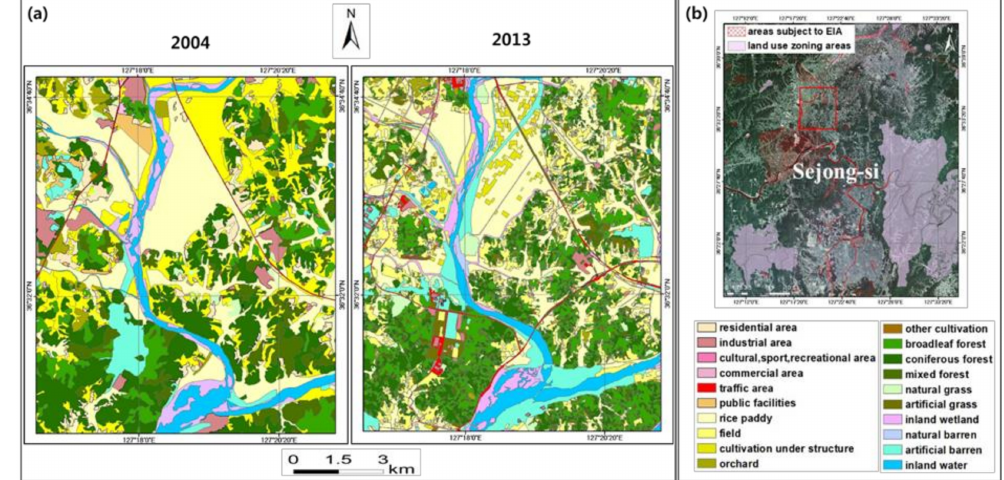
Figure 2. Examples of data used for damaged area detection in Sejong-si in South Korea. ( a ) Level 2 land cover in 2004 and 2013; ( b ) examples of areas subject to Environmental Impact Assessment (EIA) and land-use zoning areas (natural environment conservation areas) overlaid on Google Earth